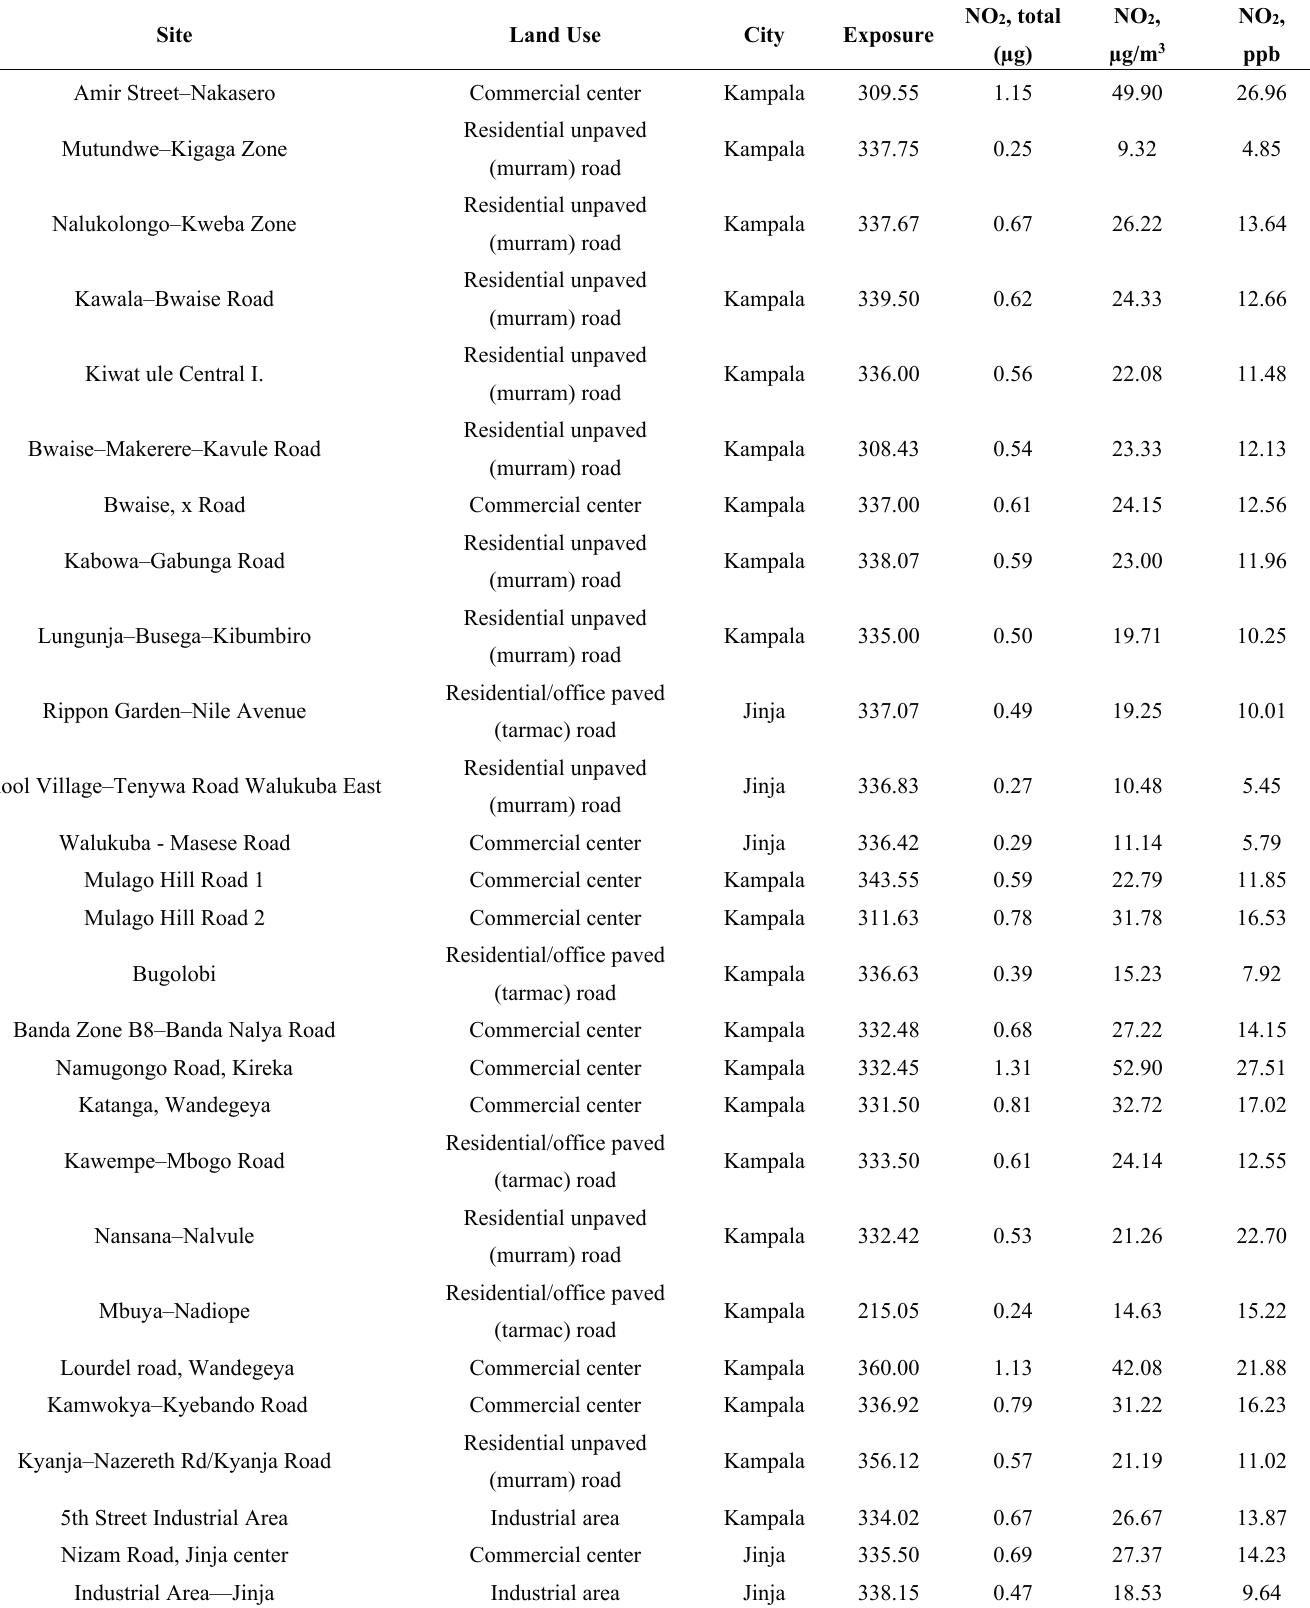
Table S2. Concentration of ambient air nitrogen dioxide at different sites in Kampala and Jinja